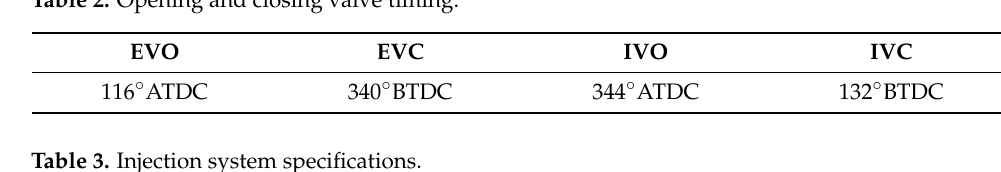
Table 2. Opening and closing valve timing.